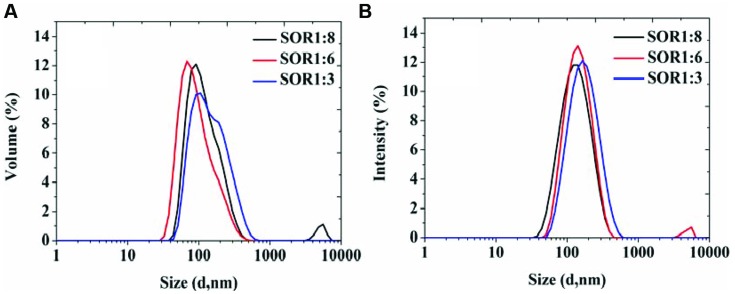
The particle size distributions of organogel-nanoemulsion prepared under different SORs were analyzed by DLS [size distributions by volume (A) and intensity (B)].